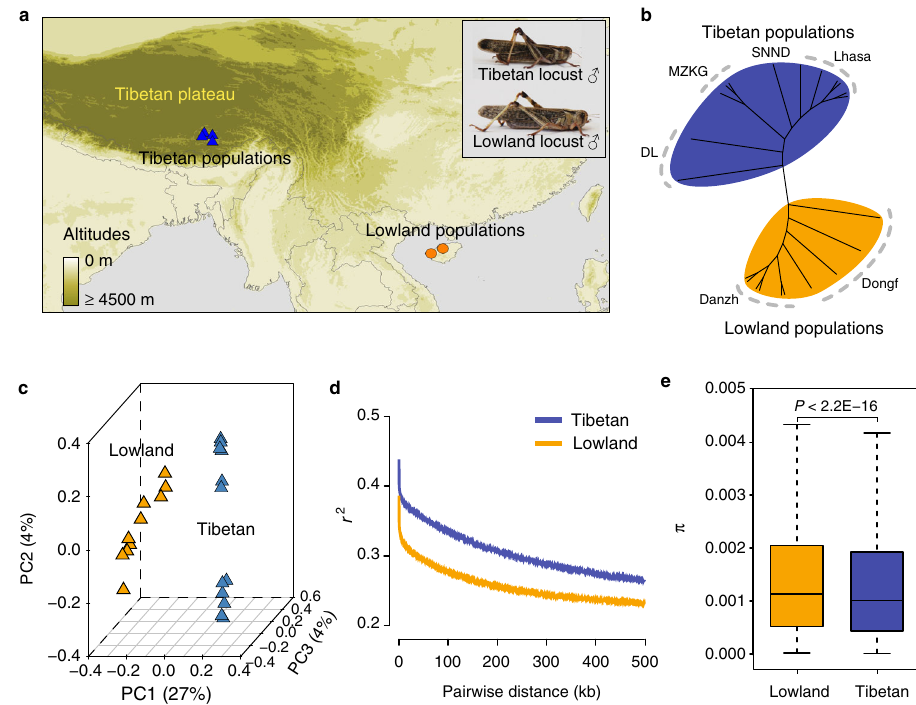
Fig. 1 Phylogenetics of migratory locust based on whole-genome SNPs. a Geographic distribution of collected locust samples used for whole-genome re- sequencing. Tibetan and lowland locusts are shown at the top-right corner. b Unrooted neighbor-joining tree of migratory locust. c Principle component (PC) analysis. d Patterns of LD (linkage disequilibrium) decay across the genome in different geographic populations. r 2 , Pearson ’ s correlation coef fi cient. e Signi fi cant difference in population nucleotide diversity ( π ), as evaluated using the Wilcoxon rank-sum test ( P < 2.2E − 16). The boxplot represents mean value and variance. Maps were generated using DIVA-GIS (http://www.diva-gis.org/). Photographs of locusts were taken by